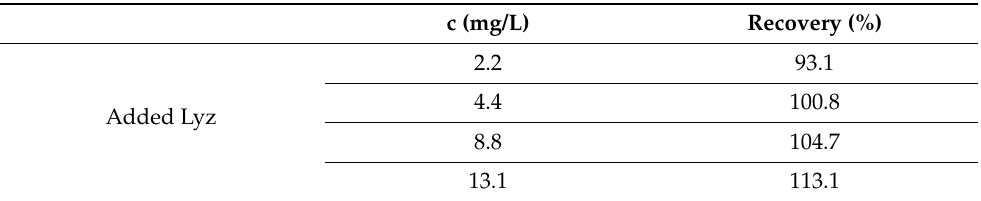
Table 2. Percentage recovery values of Lyz in artificial saliva